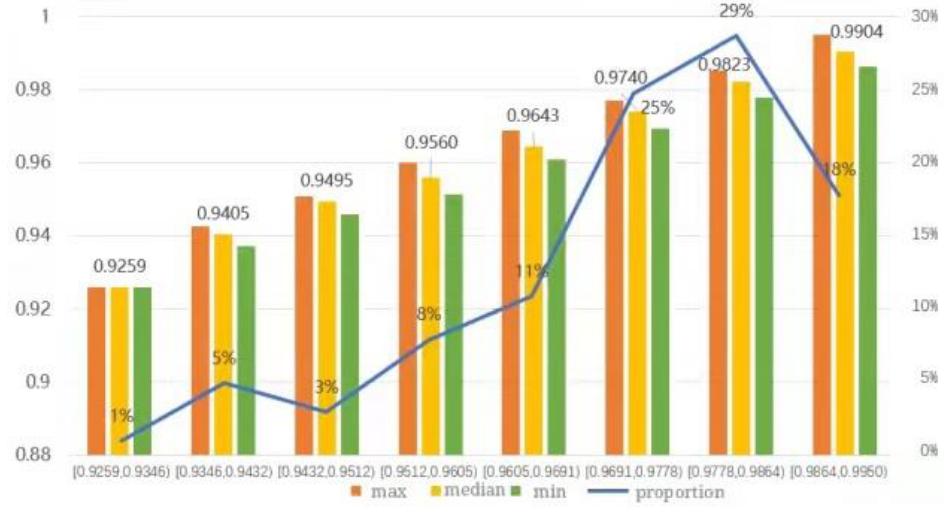
Figure 1. Distribution of SRT values.